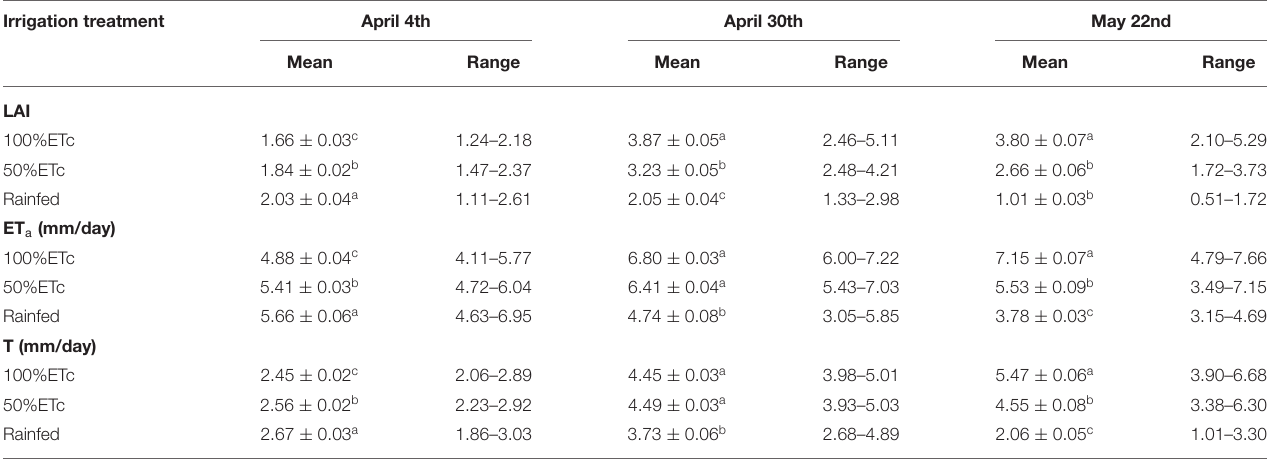
TABLE 3 | Mean values SE for LAI, daily evapotranspiration (ETa), and daily transpiration (T) assessed by remote sensing imagery for each flight date and for each ± water input treatment. Irrigation